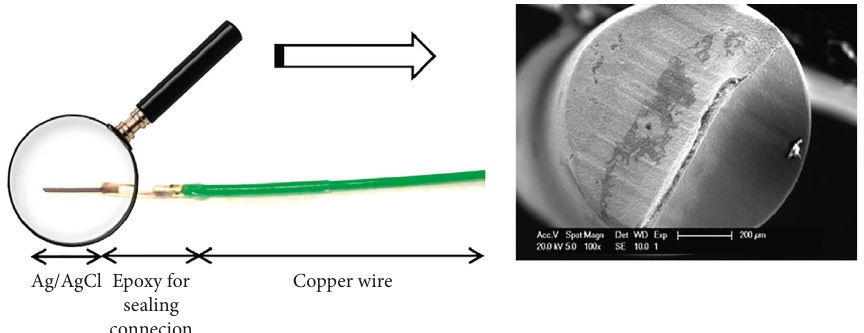
Figure 1: The as-produced Ag/AgCl chloride